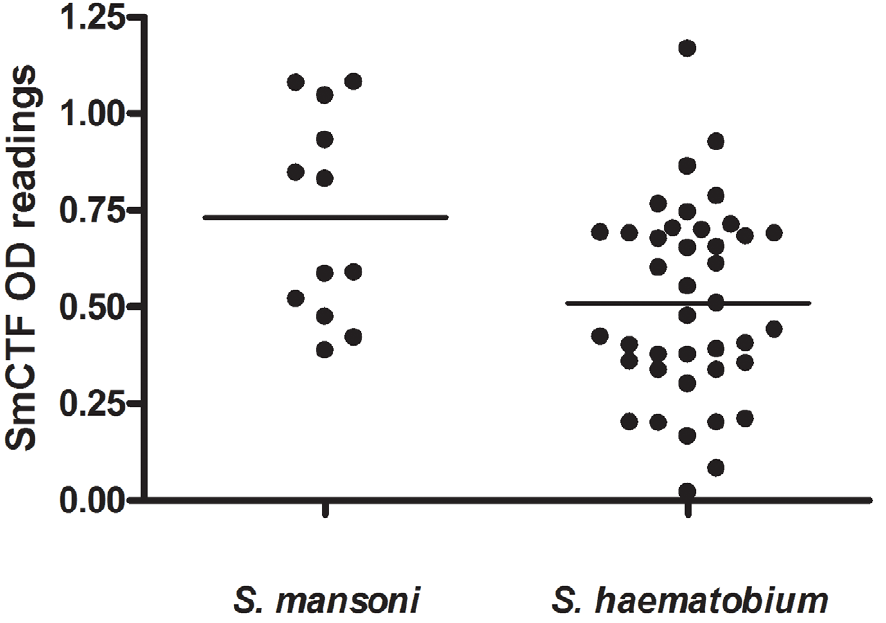
Figure 5. LSTM: comparison of S. mansoni - and S. haematobium -infection sera in ELISA. Reactivity of sera from S. mansoni and S.haematobium patients against S. mansoni cercarial transformation fluid (SmCTF). Lines indicate the mean SmCTF OD405 values for each group of sera.